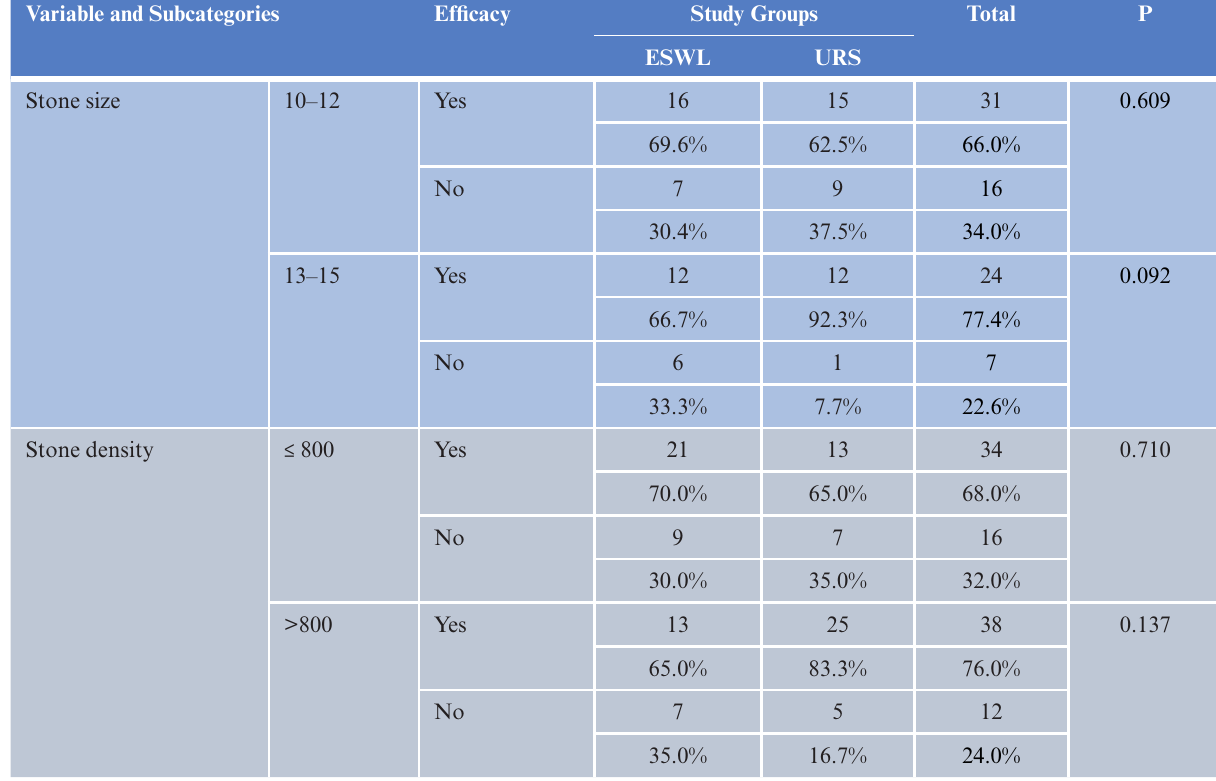
Table 2 : Comparison of density and size (mm) of stone between study groups. Variable and